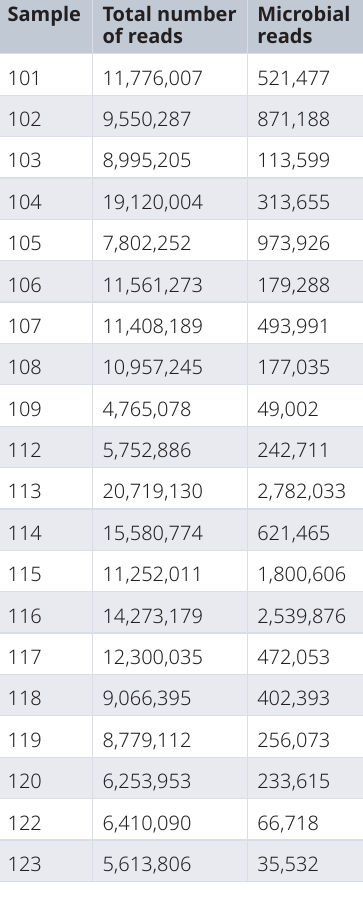
Table 1. Number of reads sequenced for each of the samples in this study. Microbial reads include all reads identified as bacteria, fungi, other eukaryotic pathogens, or viruses. Samples 119, 120, 122, and 123 are